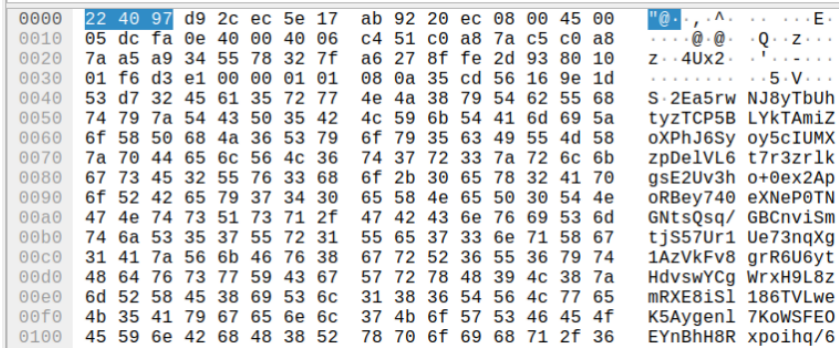
Figure 10. Non-encrypted data package capture.